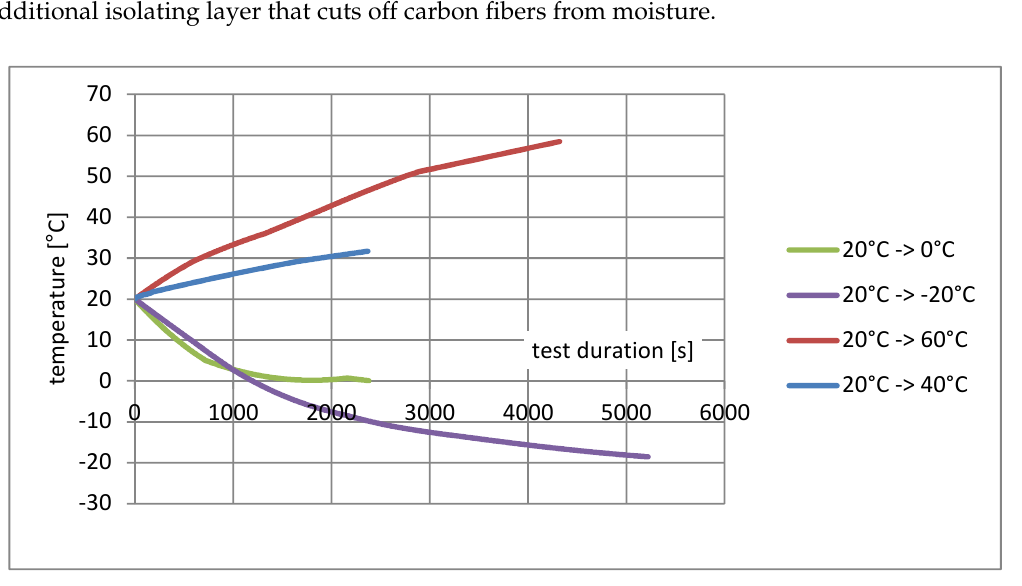
Figure 8. Paths of the temperature change during heating or cooling inside the climate chamber.